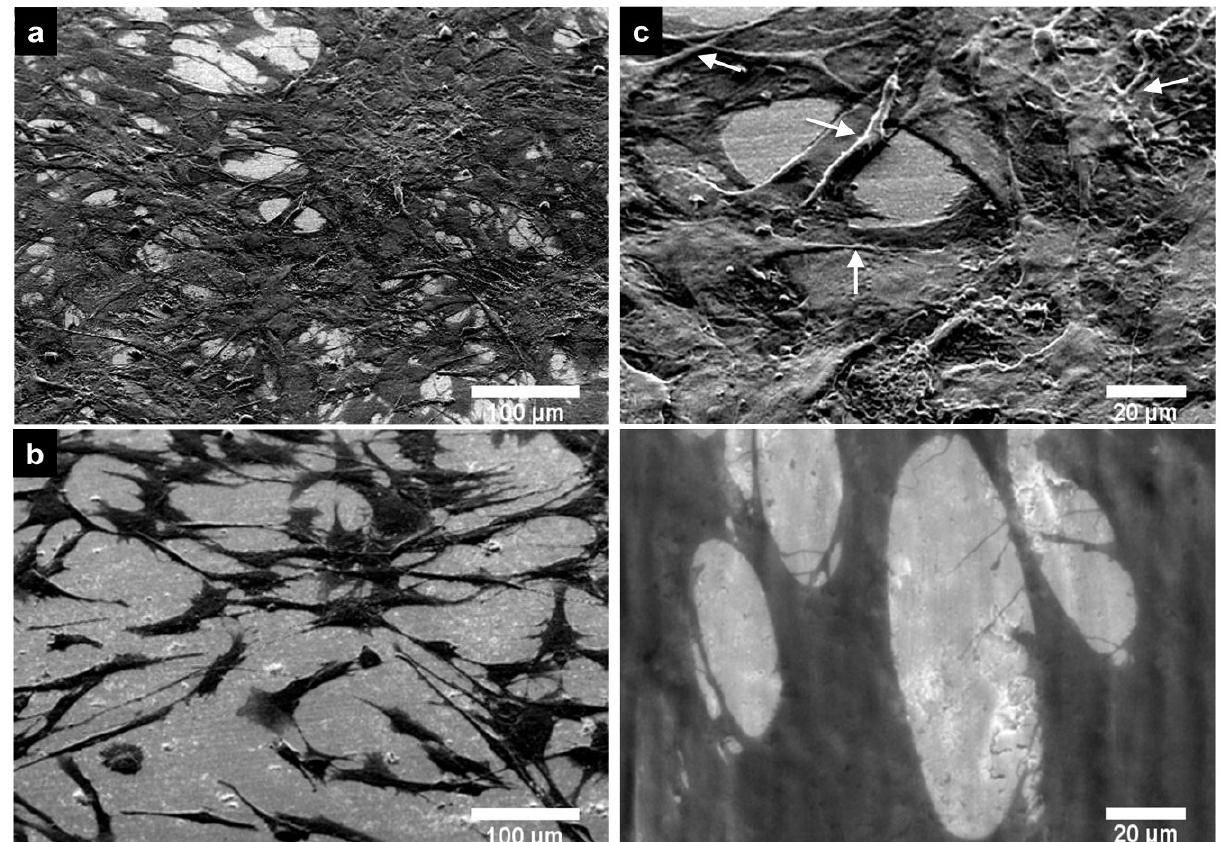
Figure 5. SEM micrographs of PPO cells at Day 3 of cell growth on the Ti6Al4V alloys. ( a ) PPO on anodized Ti6Al4V alloy; ( b ) PPO on non-anodized Ti6Al4V alloy; ( c ) PPO on anodized Ti6Al4V alloy (high magnification); ( d ) PPO on the non-anodized Ti6Al4V alloy (high magnification). White arrows denote